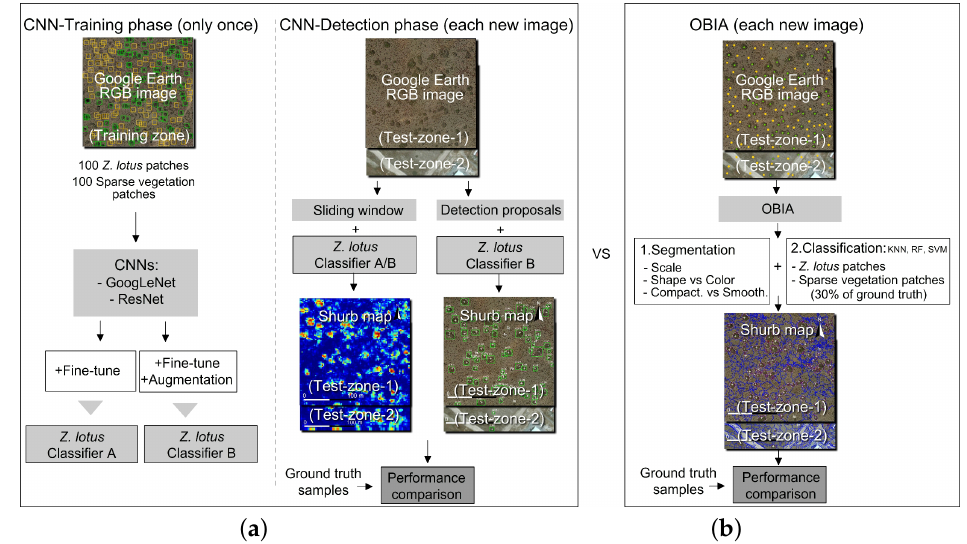
Figure 1. Flowchart of the Ziziphus lotus shrub mapping process using ( a ) Convolutional Neural Networks (CNNs) considering two detection approaches: sliding window and detection proposals and ( b ) Object-Based Image Analysis (OBIA). The best performance was obtained by ResNet-based classifier combined with the detection proposal